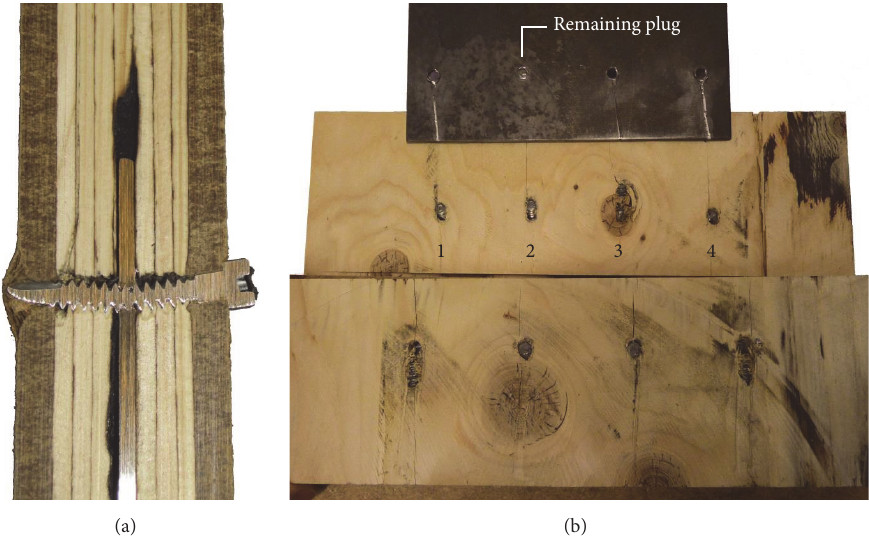
Figure 6: Failure modes for the uplift tests: (a) a cut through the screw of the specimen in the single screw uplift test, which was terminated just after the ultimate load was reached. The screw is slightly bent and is partially broken at the intersection with the steel plate (right side; cf. Figure 10(b)), indicating a brittle type of bending failure; (b) a test of the four-screw configuration after testing showing the inside of the slot where the front part of the PlyBoard has been cut off and folded down and the steel plate has been moved upwards to reveal the interior sides of the slot. It is noted that the screws are heavily indented in the LVL; screws numbers 1 and 4 are also broken at the head-shank interface eventually causing the loose parts to align parallel to the load direction; furthermore hole number 2 holds a remaining plug in the steel plate (the screw has been cut off on both sides) and the plate as well as the LVL shows evident scratch marks especially from screws 1 and